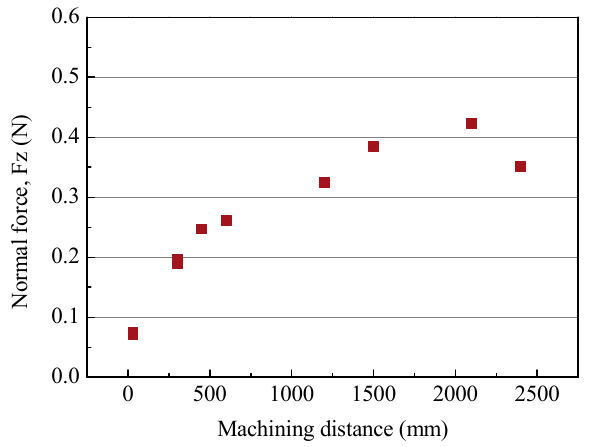
Figure 10. The cutting force according to the machining length.